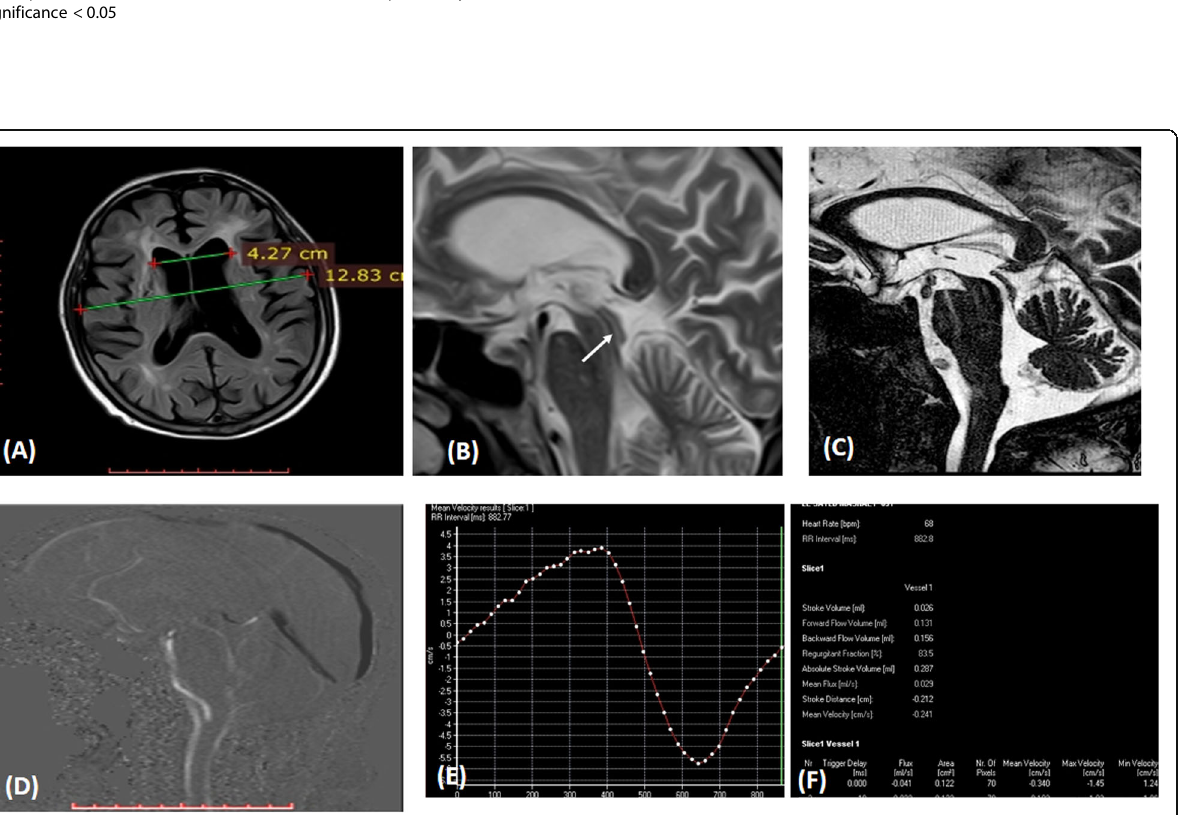
Fig. 3 Female patient aged 65 years old presented by memory disturbance, gait apraxia, and urinary incontinence. MRI ( a ) axial FLAIR at the level of the lateral ventricle showing hydrocephalus (Evan index = 0.33). b Sagittal T2 WI showing the signal void sign at the aqueduct (white arrow). c 3D DRIVE image showing patent normal aqueduct. d CSF flow in the aqueduct of Sylvius as shades of white. Sagittal phase image in systole showing ( e ) velocity-time curve showing CSF in both diastole (above the base line) and systole (below the base line). PDV = 3.9 cm/s, PSV = 5.8 cm/s. Vmax = (3.9 + 5.8)/2 = 4.85 cm/s. f CSF flow curve associated table demonstrating the following: forward flow volume = 131 μ l, and backward flow volume = 156 μ l, and so the SV = (131 + 156)/2 = 143.5 μ l/cycle. Aqueduct area = 0.122 cm 2 . So the maximum flow was calculated as following: maximum flow = 4.85 × 0.122 = 0.5917 cm 3 /s. The diagnosis is hyperdynamic CSF circulation consistent with